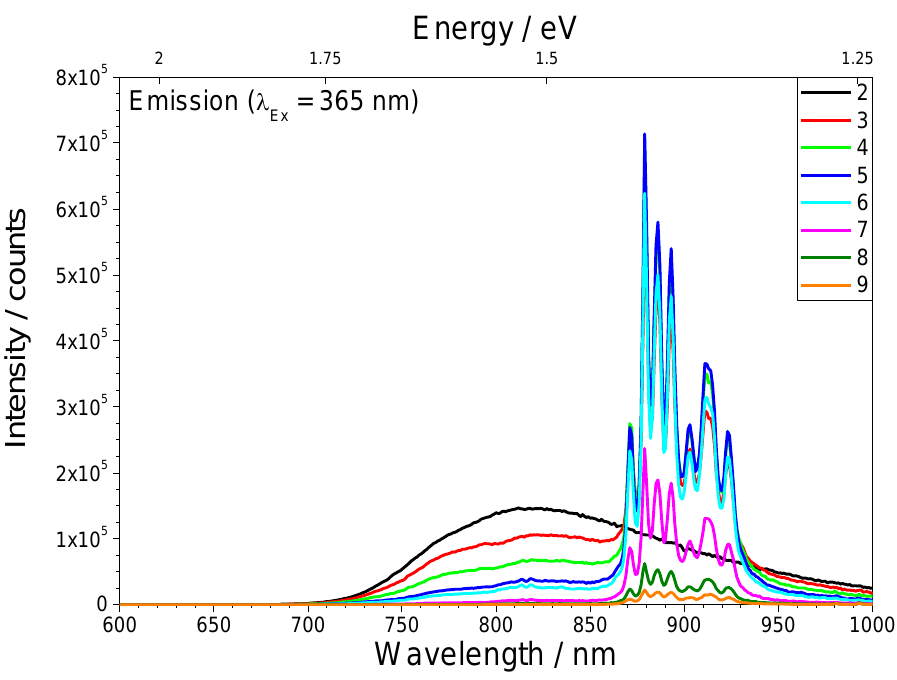
Figure 4. Emission spectra of Ca 2 MgWO 6 doped with 1% Cr 3+ and (0 – 8)% Nd 3+ and double amount of Li + and Na